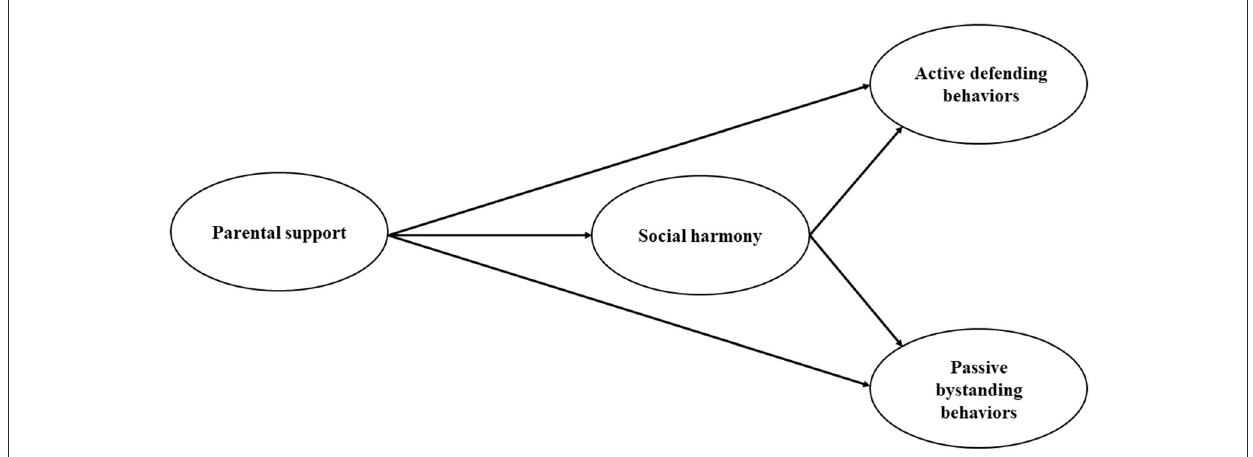
FIGURE1 Hypothesized conceptual